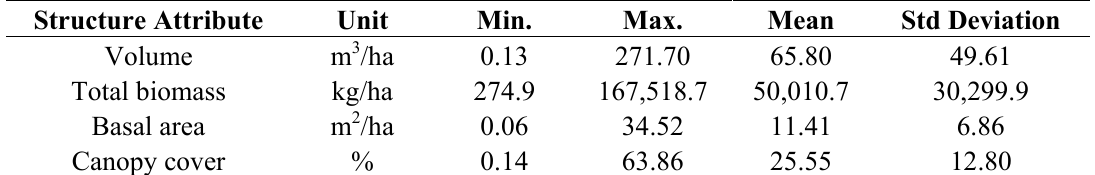
Table 1. Summary statistics of plot-level forest structure attributes ( r = 25m).